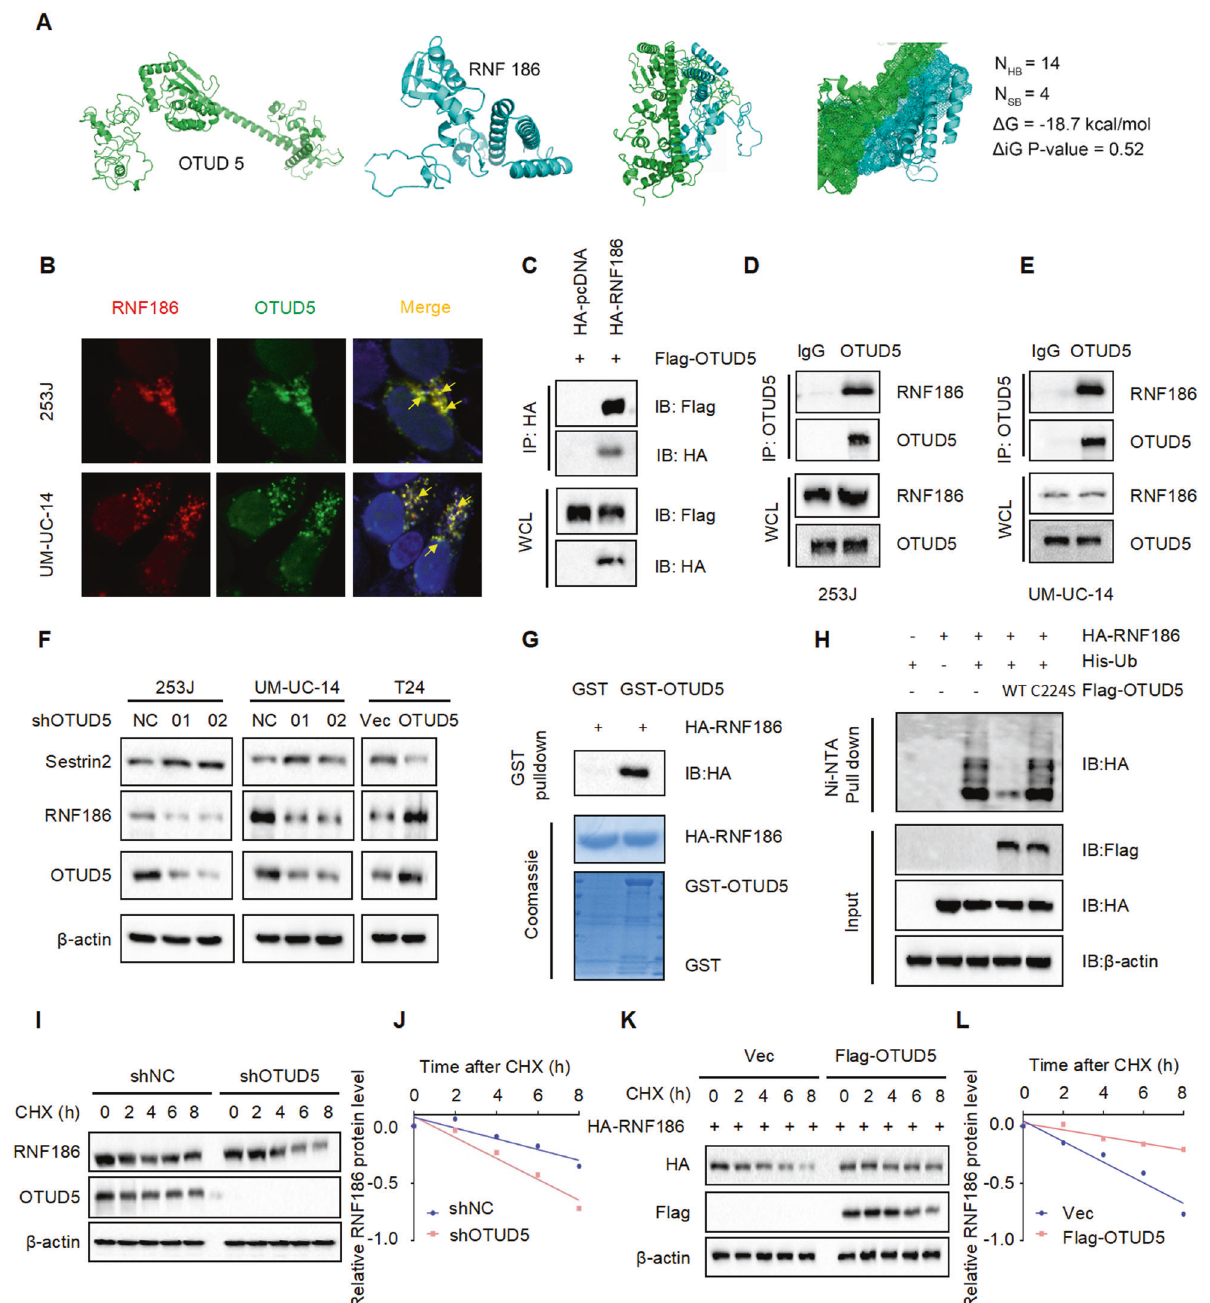
Fig. 5 OTUD5 stabilizes RNF186 by deubiquitination, leading to sestrin2 degradation. A Protein binding prediction chart for OTUD5 and RNF186. B Confocal immuno fl uorescence microscopic analysis of OTUD5 and RNF186 in 253 J and UM-UC-14 cells. Scale bars represent 10 μ m. C IB analysis of WCL and anti-HA immunoprecipitates (IPs) derived from 293 T cells transfected with Flag-OTUD5 and HA-tagged RNF186, pcDNA3.1 was used as the control. D , E OTUD5 interacts with RNF186. Co-immunoprecipitation (co-IP) of OTUD5 and RNF186 was assayed in 253 J and UM-UC-14 cells. Immunoprecipitation (IP) was performed using the antibody against OTUD5, and the endogenous interaction between OTUD5 and RNF186 was determined by Western blotting using the antibody against RNF186. F IB analysis of WCL derived from 253 J and UM-UC-14 cells stably expressing shOTUD5 and T24 cells stably overexpressing OTUD5. RNF186 and sestrin2 were detected, β -actin was used as the loading control. G GST pull-down assay revealed the direct interaction between RNF186 and OTUD5. The upper panel presents the result of IB using the antibody against HA, and the lower panels show Coomassie blue staining of the puri fi ed proteins. H IB analysis of WCL and Ni-NTA pull-down products derived from 293 T cells transfected with Flag-OTUD5 WT, Flag-OTUD5 C224S, HA-RNF186 and His-Ub. 20 μ M MG132 was added 6 h before harvesting the cells. I OTUD5 knockdown cells (shOTUD5) as well as parental UM-UC-14 cells (shNC) were treated with 100 μ g/ml cycloheximide (CHX) for the indicated time period before harvesting. Equal amounts of WCL were immunoblotted with the indicated antibodies. J Quanti fi cation of the band intensities in ( I ). RNF186 levels were normalized to the corresponding β -actin levels, then normalized to the t = 0 h RNF186 level. K IB analysis of WCL derived from 293 T cells transfected with HA-RNF186, Flag-EV and Flag-OTUD5. Cells were treated with 100 μ g/ml CHX for the indicated time period before harvesting. EV empty vector. L Quanti fi cation of the band intensities in K . RNF186 levels were normalized to the corresponding β -actin levels, then normalized to the t = 0 h RNF186 level. All data are presented as mean ± SD of 3 independent experiments. Cell Death and Disease (2022)